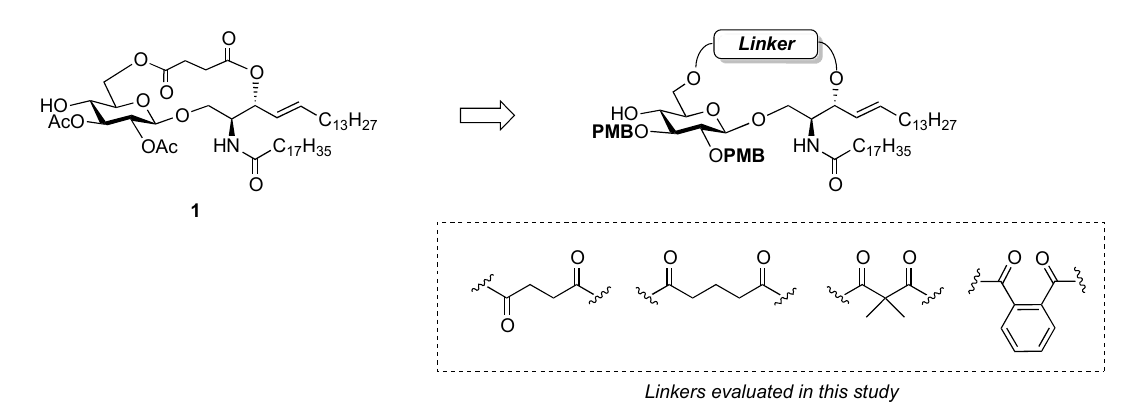
Figure 1. Structure of our previously reported cyclic GlcCer cassette acceptor ( left ). Structure of newly designed cyclic GlcCer cassette acceptor ( right